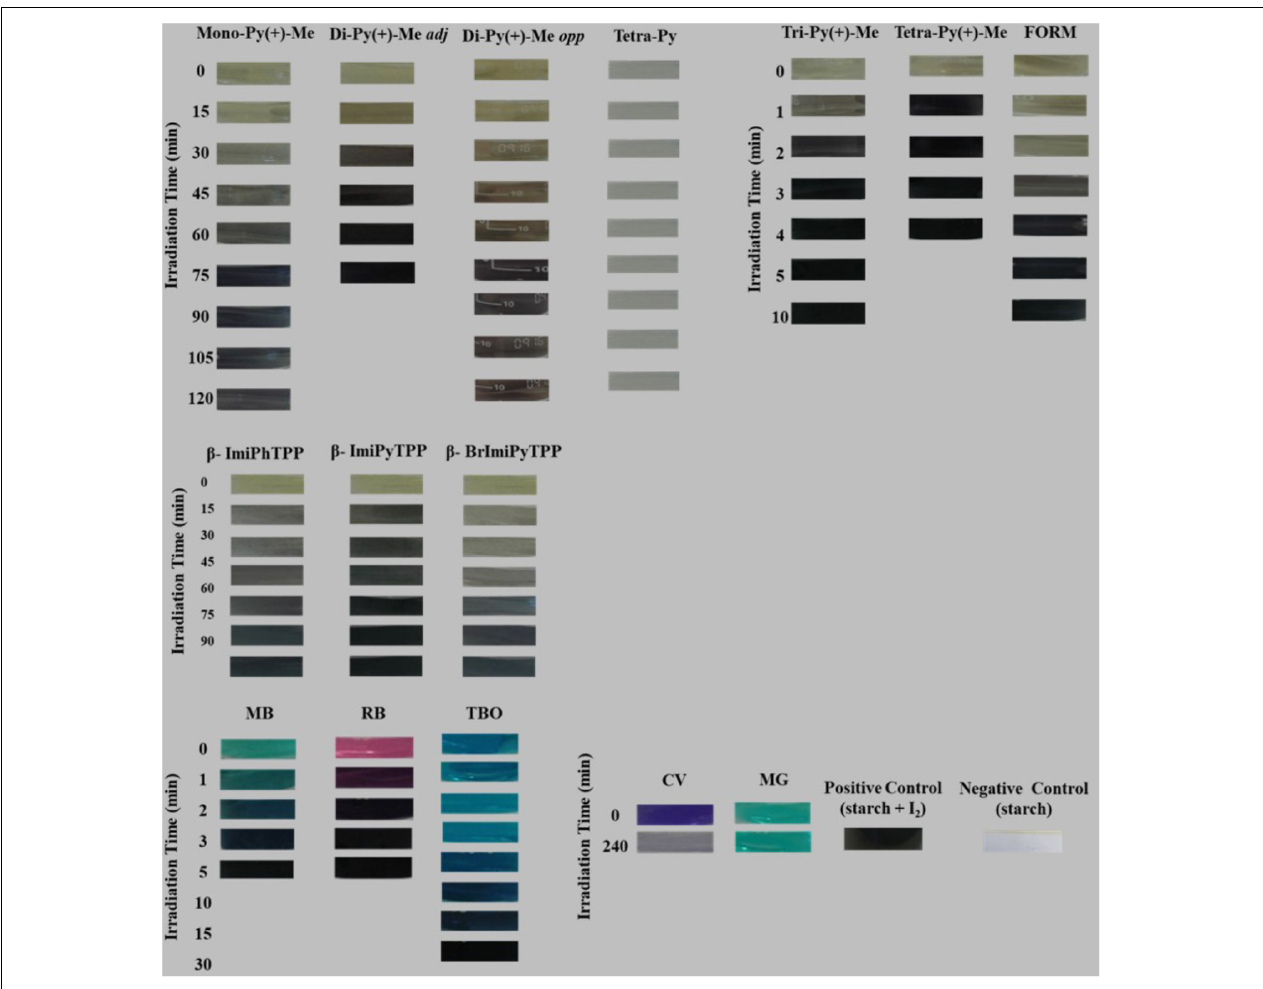
FIGURE 8 | Visual appearance of the starch solutions after different irradiation periods in the presence of each PS at 5.0 µ M and KI at 100